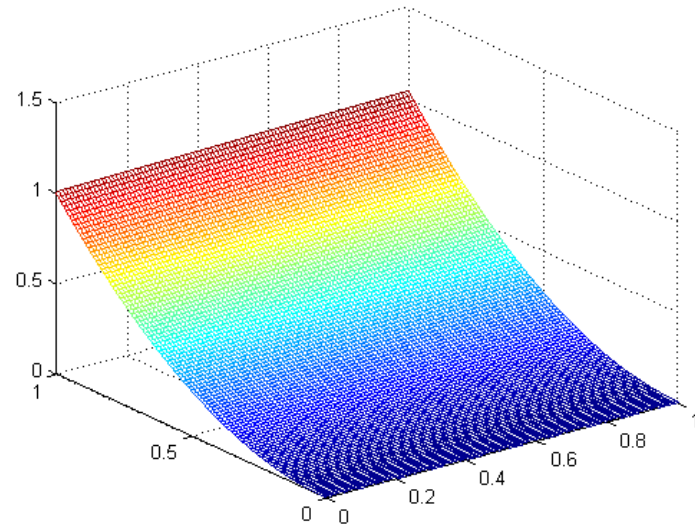
Figure 3. The Exact Solutions u ( x , t ) for Equation (40) when µ = ν = 1.